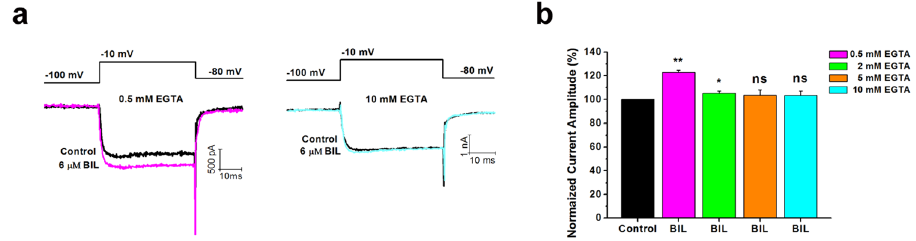
Figure 6. A high concentration of EGTA (2 mM, 5 mM and 10 mM) prevented cells from bilirubin induced enhancement of Ca 2 + currents. ( a ) Representative traces at − 10 mV for currents obtained in the presence or absence of 6 μ M bilirubin (black trace) with 0.5 mM EGTA (magenta trace, left panel) and 10 mM EGTA (cyan trace, right panel) in intracellular solutions. Each current was elicited by a 40 ms test pulse to − 10 mV from − 100 mV. ( b ) The normalized VGCC current amplitude before (black bar) and during application of 6 μ M bilirubin with pipette solutions containing 0.5 mM EGTA (magenta bar), 2 mM EGTA (green bar), 5 mM EGTA (orange bar) and 10 mM EGTA (cyan bar). * P < 0.05, ** P < 0.01 , ns, not significant, one-way ANOVA with Bonferroni post hoc test.